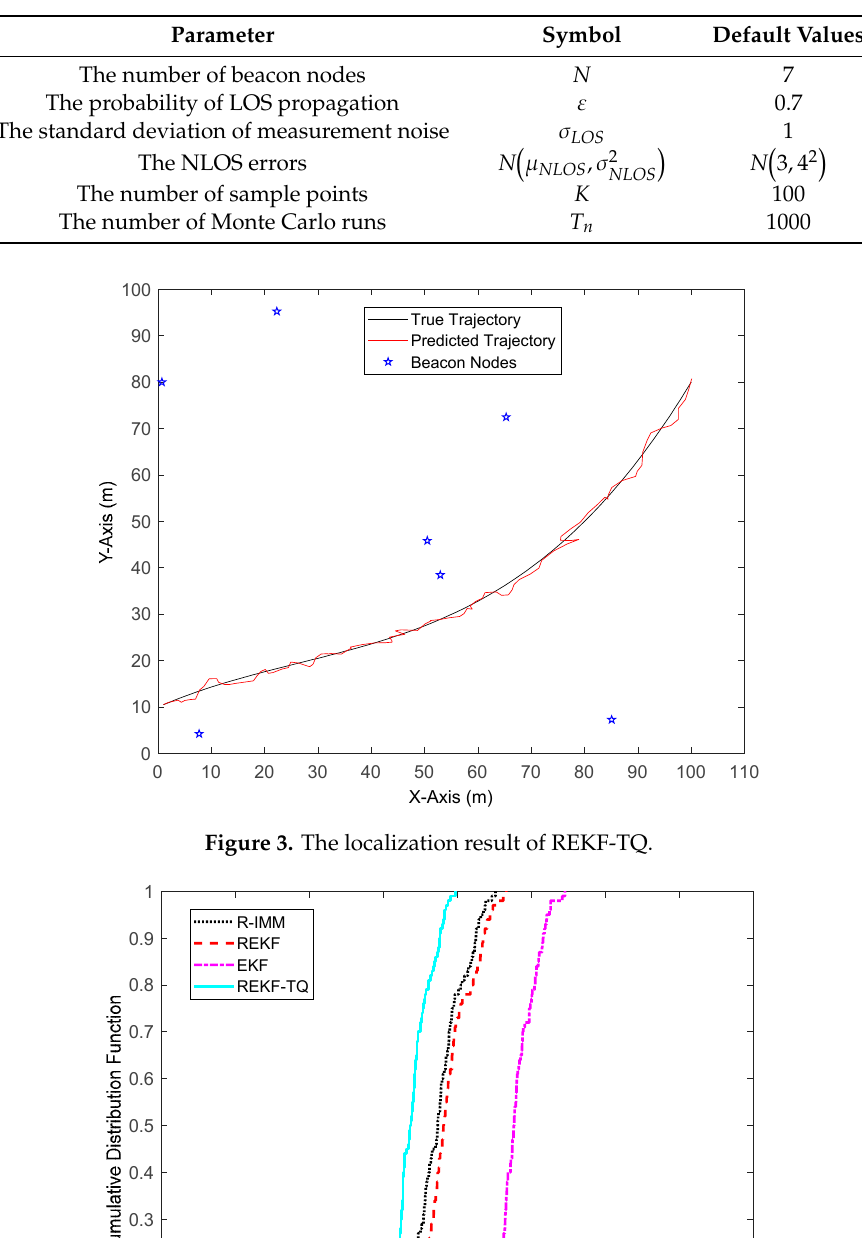
Table 1. The default parameters of a Gaussian distribution.